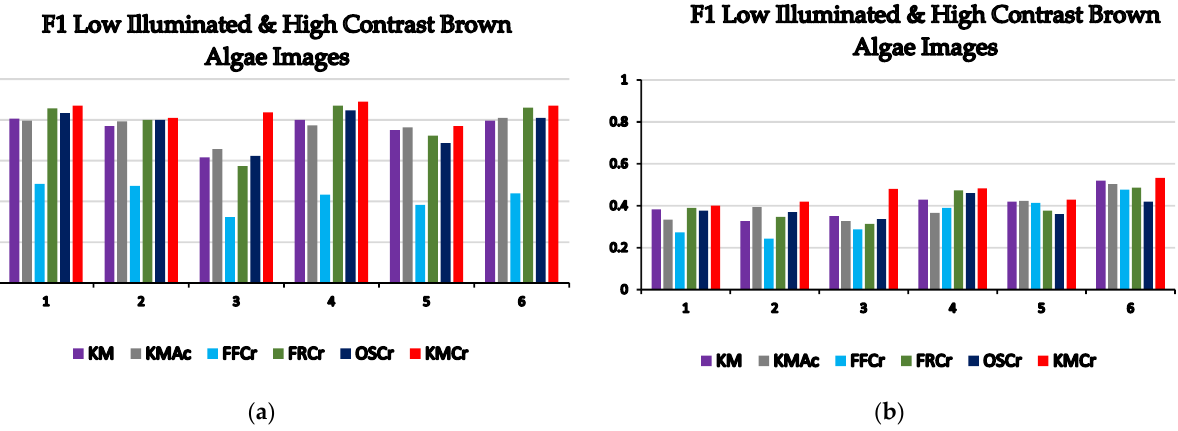
Figure 10. The results of evaluating the tested segmentation algorithms using low illuminated and high contrast brown algae images. Images (1 – 3) had two categories, and (4 – 6) had three categories: ( a ) F1-score; ( b ) IOU.